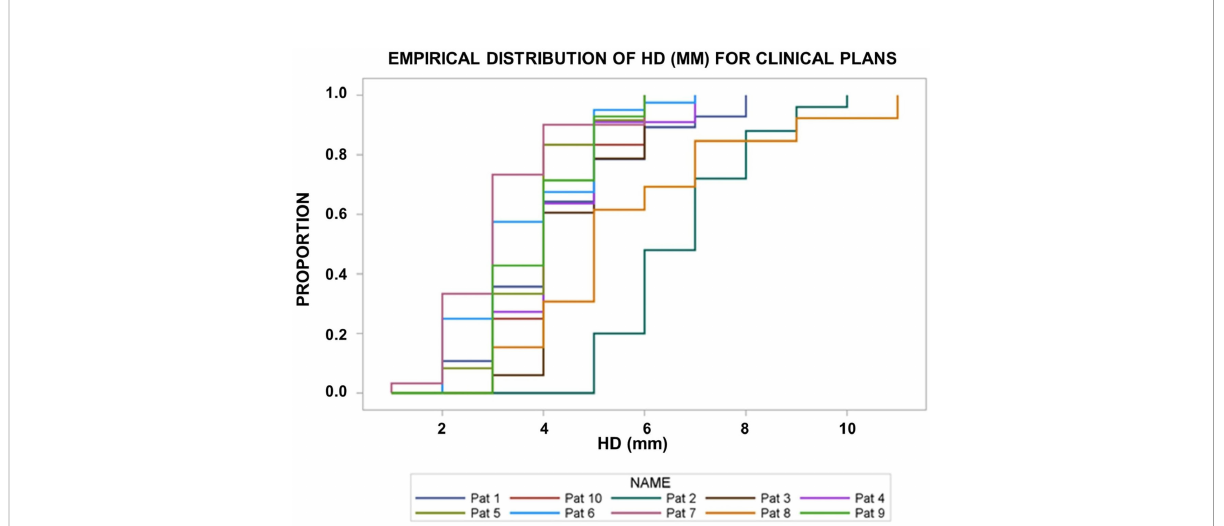
FIGURE 5 Empirical distribution functions of the Hausdorff distances (HD, in mm) of the deformed CTV i on the pre-fraction cone beam CTs ’ from the original CTV in the planning CT. There was signi fi cant interpatient heterogeneity ( p < 0.0001, Kruskal – Wallis